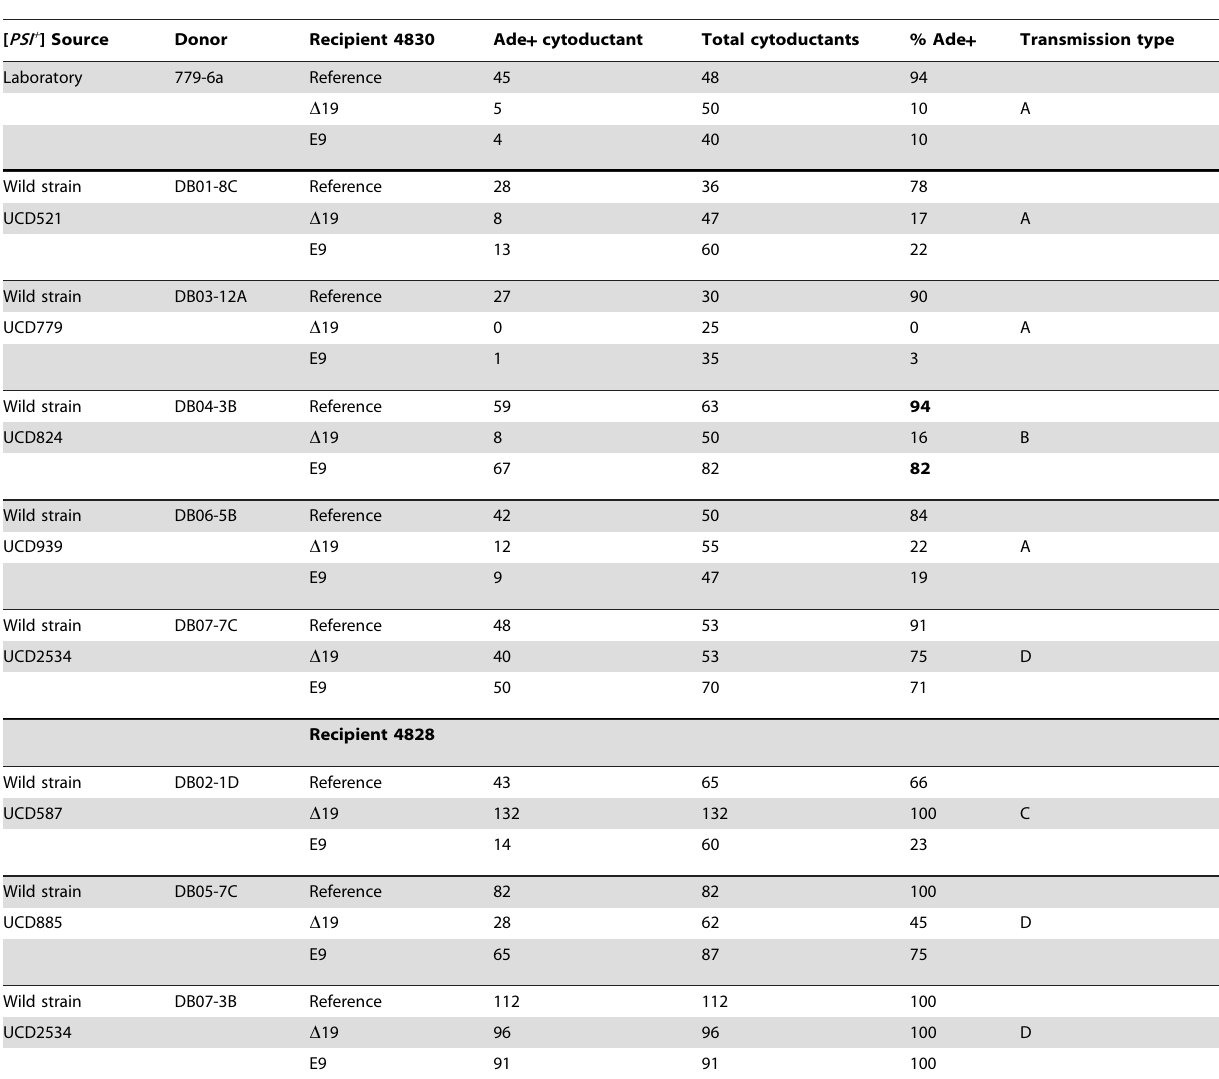
Table 7. Wild [ PSI + ] prion isolates are largely sensitive to polymorph-determined transmission